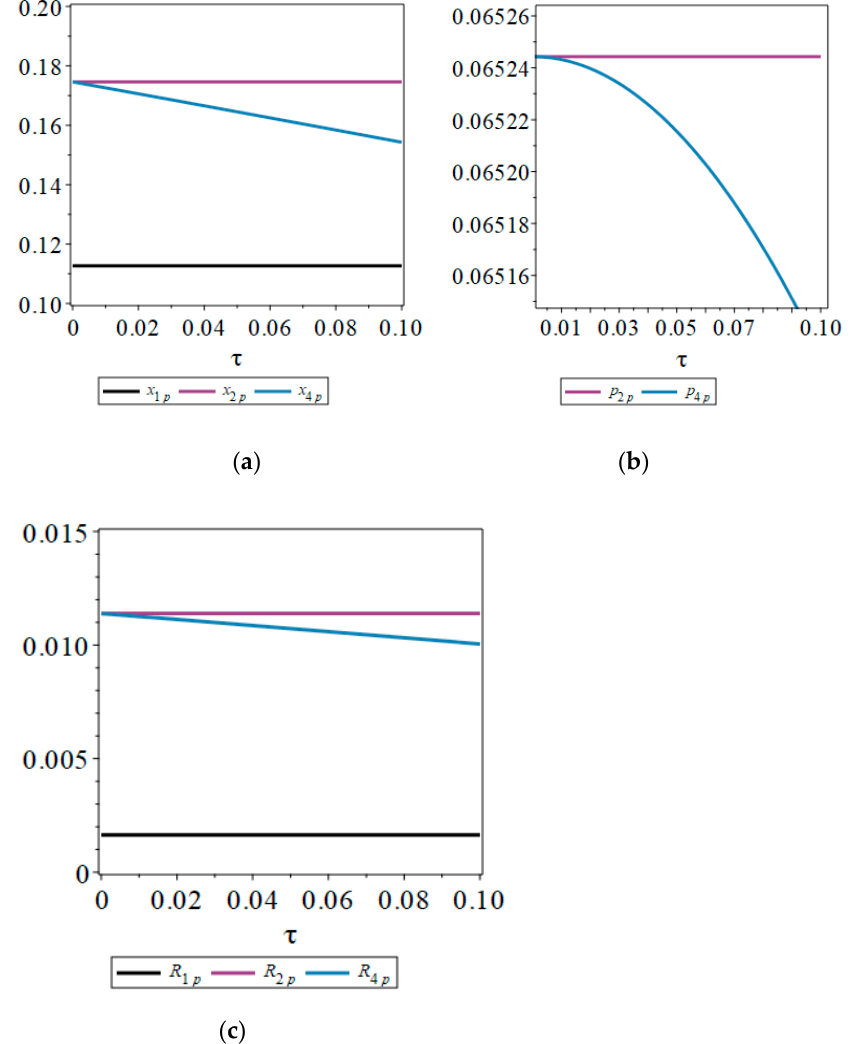
Figure 3. The comparison between different strategies: ( a ) the demands (b) the prices. (c) the reve-